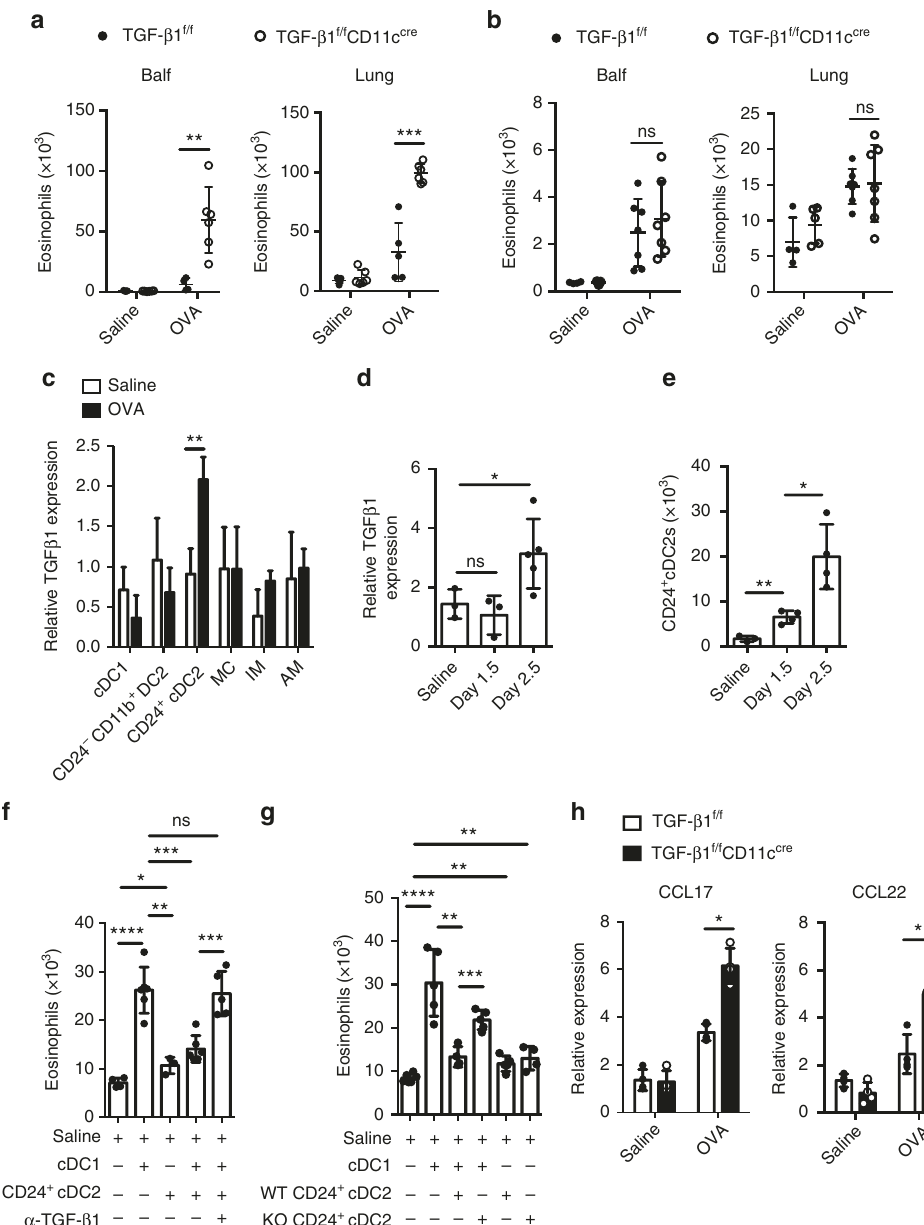
Fig. 5 Lung CD24 + cDC2s inhibit cDC1-mediated eosinophil migration via TGF- β 1. a , b Quanti fi cation of eosinophils in Balf and lung from TGF- β 1 fl / fl CD11c Cre (empty circle) and TGF - β 1 fl / fl (solid circle) mice 2.5 days ( a , n = 5 – 6 mice per group) or 1.5 days ( b , n = 4 – 5 mice for saline groups and n = 7 mice for OVA groups) after the fi rst OVA challenge. c mRNA expression of TGF - β 1 by pulmonary cDC1, CD24 + cDC2, CD24 − CD11b + DC2, MC, IM and AM populations separated from C57BL/6 mice 2.5 days after the fi rst OVA (solid rectangle) or saline (empty rectangle) challenge. d mRNA expression of TGF- β 1 by pulmonary CD24 + cDC2s separated from C57BL/6 mice 0, 1.5, or 2.5 days after the fi rst OVA challenge. mRNA expression is relative to the expression of cDC1s ( c ) or CD24 − CD11b + DC2s ( d ) from saline-treated mice. n = 3 – 5 per group. e Counts of CD24 + cDC2s in lungs from C57BL/6 mice 0, 1.5, or 2.5 days after the fi rst OVA challenge. f Counts of eosinophils recruited into the air pouches injected with pulmonary cDC1s or CD24 + cDC2s (1 × 10 4 cells, 200 μ l) puri fi ed from C57BL/6 mice 2.5 days after the fi rst OVA challenge with anti-TGF- β 1 (10 μ g per ml) antibody or mouse IgG1 isotype control. n = 4 – 6 mice per group. g Counts of eosinophils recruited into the air pouches injected with pulmonary cDC1s, and CD24 + cDC2s (1 × 10 4 cells, 200 μ l) puri fi ed from TGF- β 1 fl / fl CD11c Cre (KO) and TGF- β 1 fl / fl (WT) mice 2.5 days after the fi rst OVA challenge. n = 4 – 6 mice per group. h mRNA expression of CCL17 and CCL22 chemokines by lung cDC1s (SiglecF − CD11c + IA/IE + CD103 + CD11b − ), separated from TGF - β 1 fl / fl CD11c Cre (solid rectangle) and TGF- β 1 fl / fl (empty rectangle) mice 2.5 days after the fi rst OVA challenge. n = 4 – 5 per group. * P < 0.05, ** P < 0.01, *** P < 0.001, unpaired Student ’ s t test. Means ± SD are shown. Data represent two ( c , d ) and three ( a , b , e – h ) independent